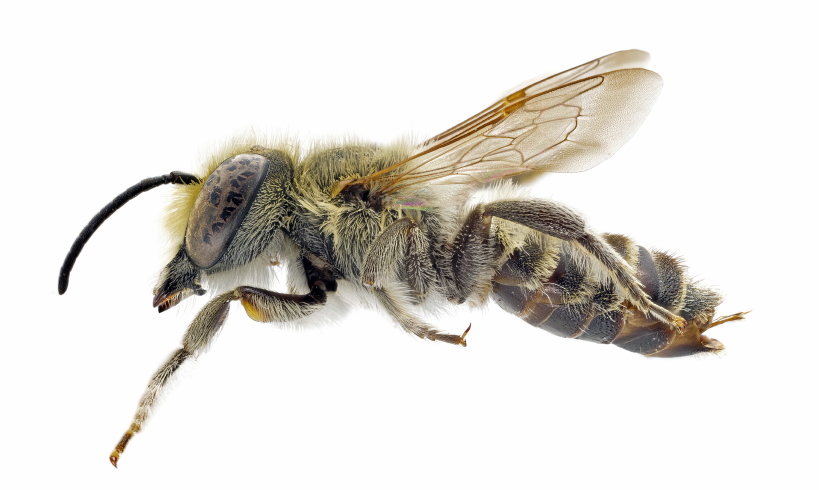
Figure 2. Megachile pilidens transverse gynandromorph from Berici Hills (North-Eastern Italy). Number of antennal segments : The number of flagellomeres is 11, except for one specimen with 10, but the last one is almost twice the length of the previous one (Figure 3). In two specimens the number of flagellomeres is 11, but the last two are partially fused.